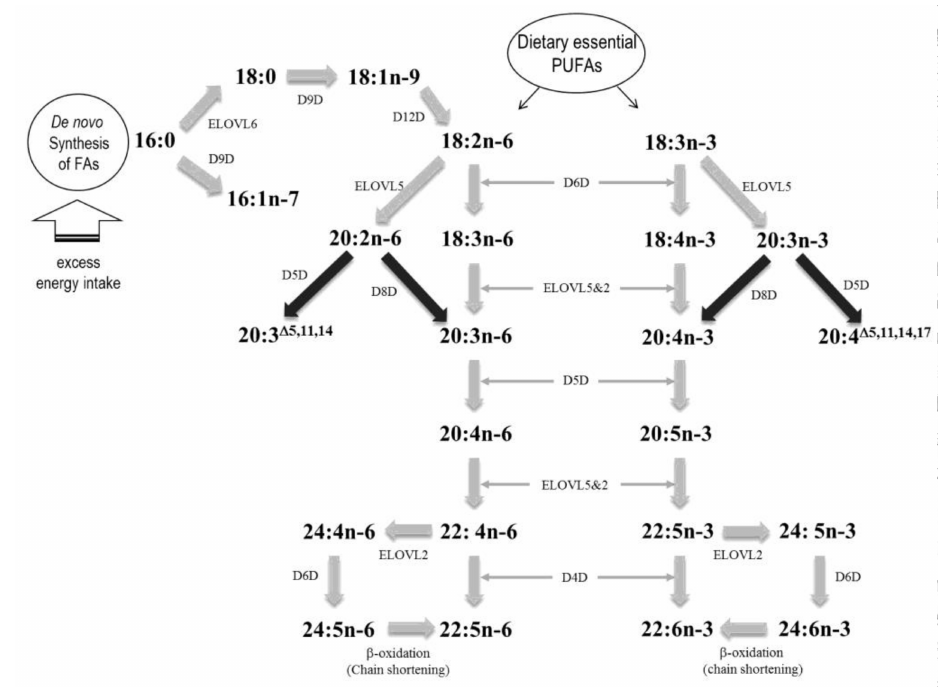
Figure 1. Fatty acids elongation and desaturation pathways. PUFAs, polyunsaturated fatty acids; FAs, fatty